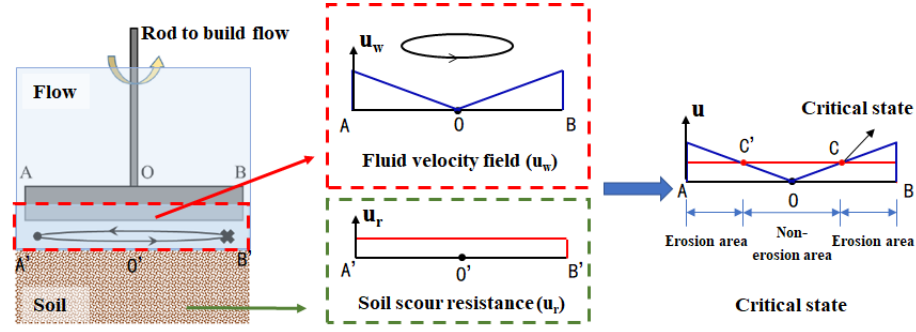
Figure 6. Erosion zone and non-erosion zone division in the simplified scour resistance test.